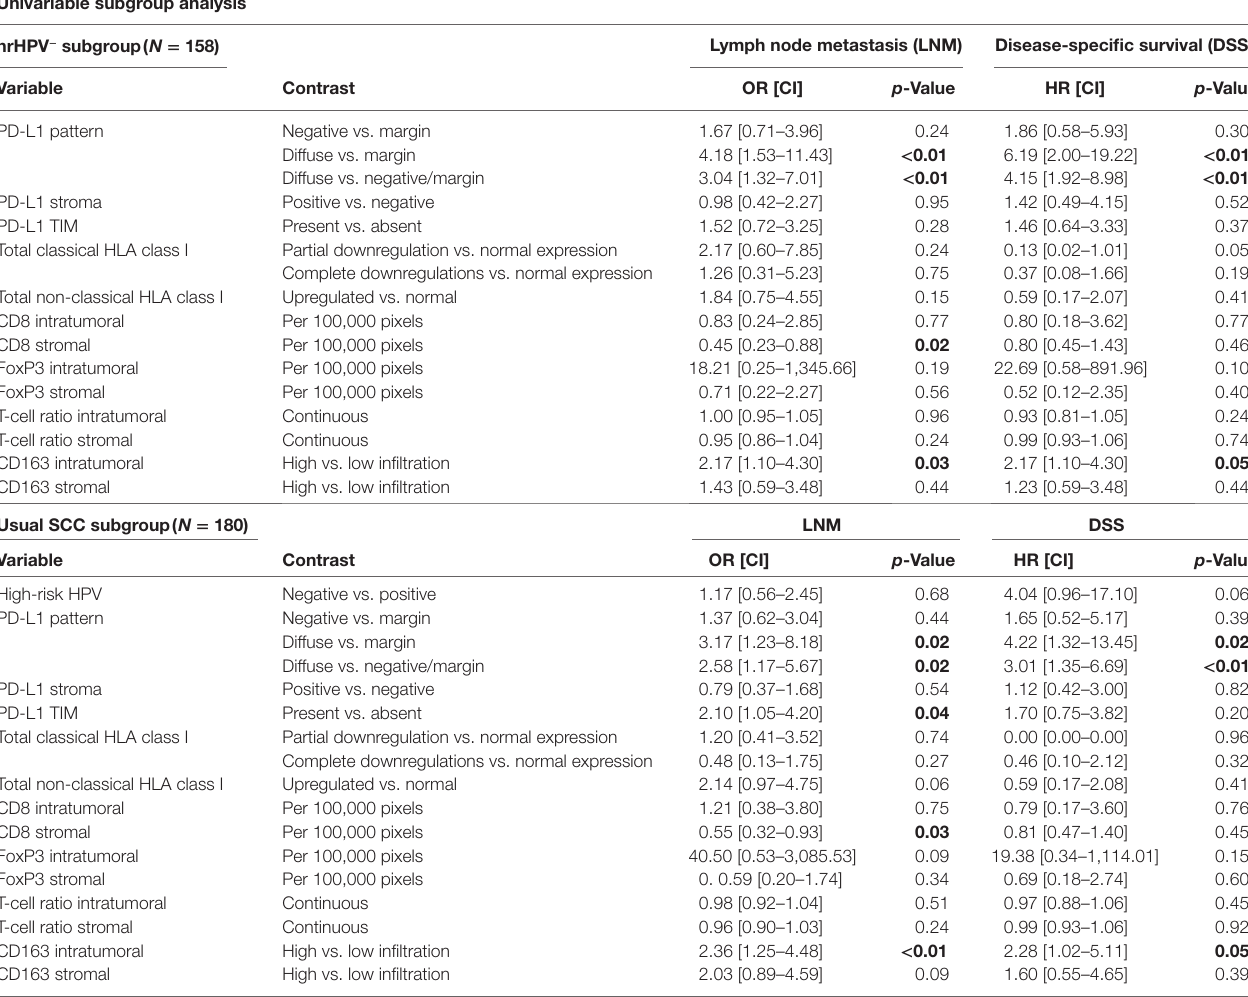
TaBle 4 | Univariable subgroup analysis. Univariable subgroup